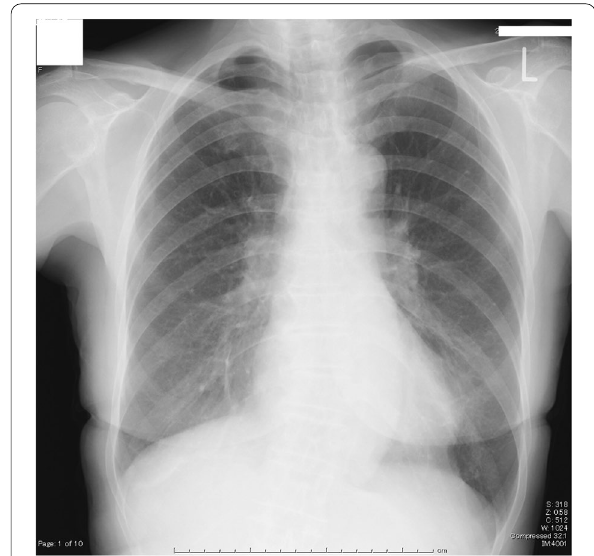
Fig. 3 Preoperative chest X-ray did not show any